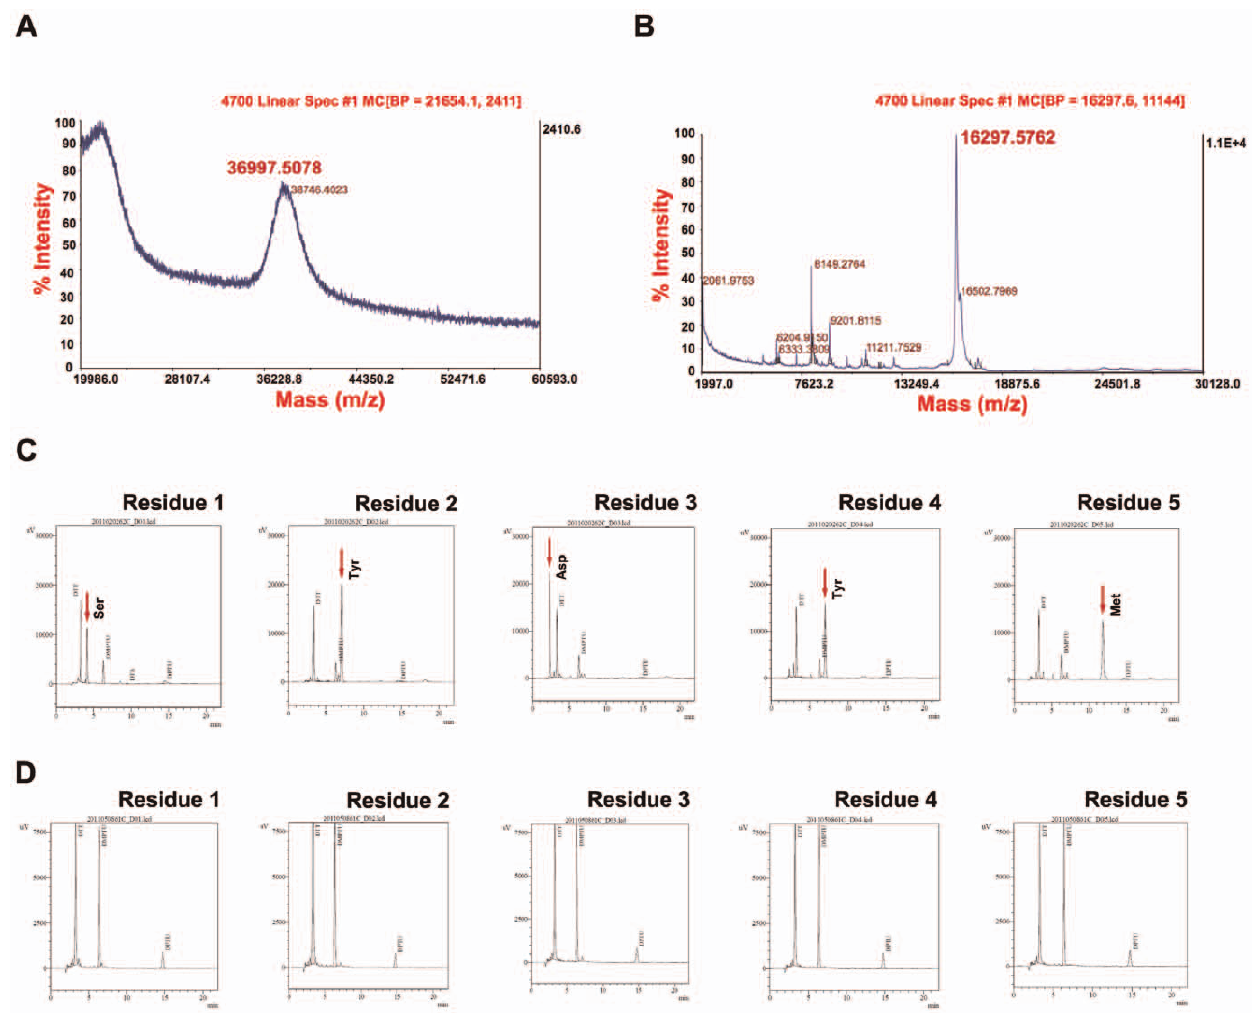
Figure 3. Validation of the solid-phase PEGylated rhKGF-1. Panel A, MALDI-TOF mass spectrometry of PEGylated rhKGF-1 showing the molecular mass of PEGylated rhKGF-1 (36997 Da). Panel B, MALDI-TOF mass spectrometry of non-PEGylated rhKGF-1 showing the molecular mass of non-PEGylated rhKGF-1 (16297 Da). Panel C, D. N-terminal sequencing of non-PEGylated and PEGylated rhKGF-1 by Edman degradation method.